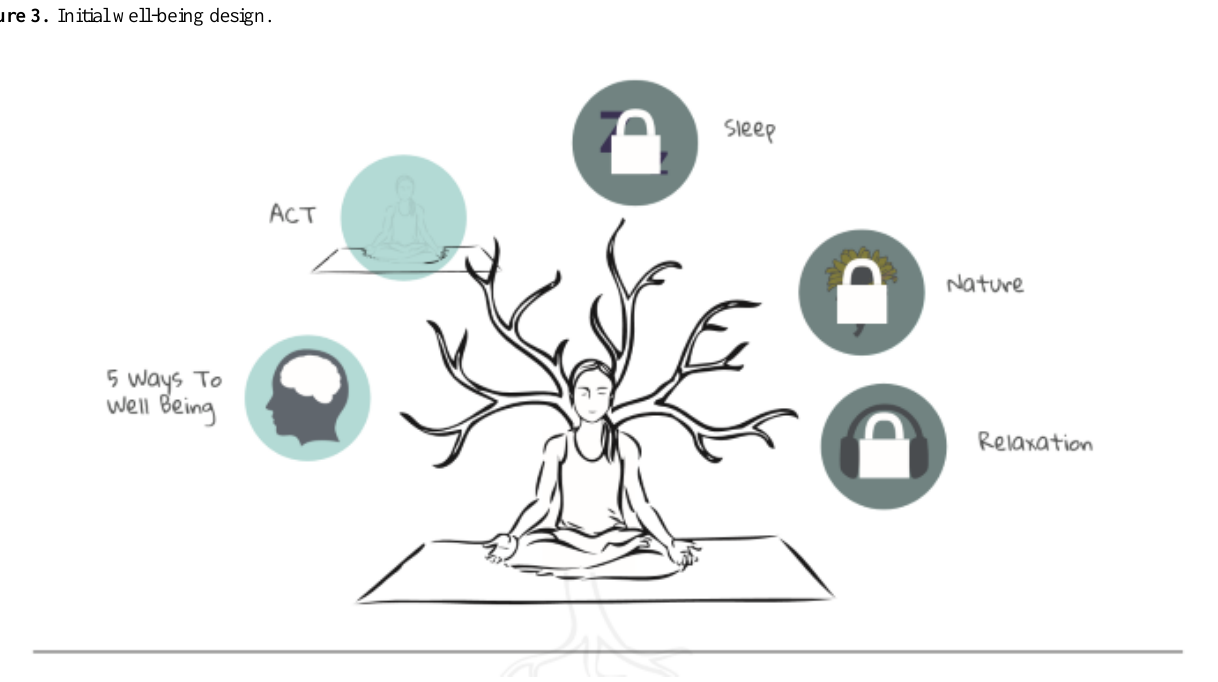
Figure 3. Initial well-being